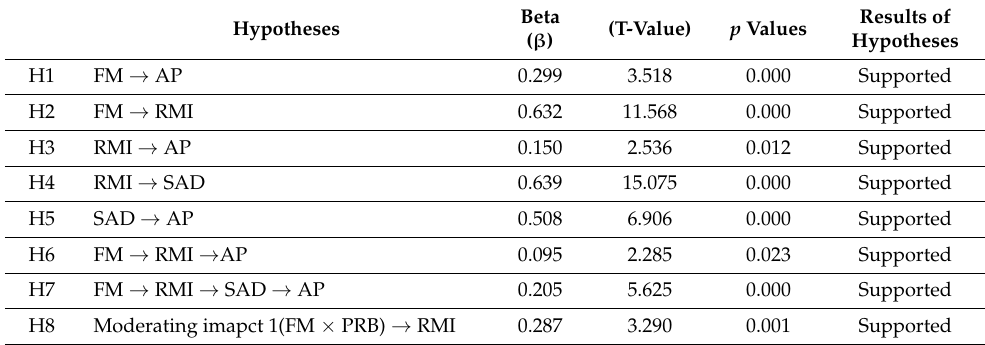
Table 5. The structural inner model